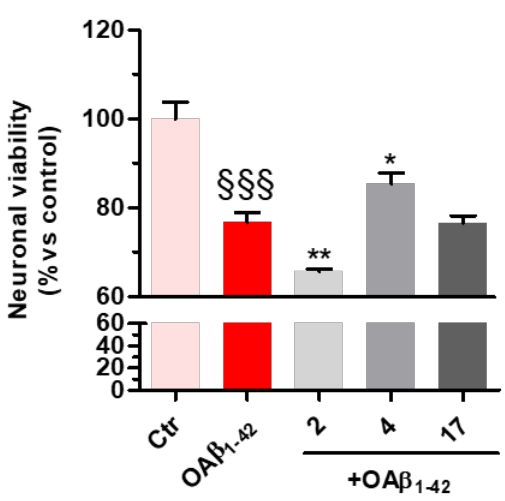
Figure 8. Effects of compounds 2 , 4 and 17 on the neurotoxicity induced by OA β 1–42 in SH-SY5Y cells. Cells were incubated with compounds 2 , 4 , 17 (1.25 µ M) and OA β 1–42 (10 µ M) for 4 h. At the end of incubation, the neuroprotective activity of the compounds was detected by the solubilization of intracellular MTT granules in Tween-20, as described in the Materials and Methods section. Data are expressed as percentage of neuronal viability and reported as mean ± SEM of three independent experiments ( §§§ p < 0.001 vs. control, * p < 0.05 and ** p < 0.01 vs. cells treated with OA β 1–42 at one way ANOVA with Bonferroni post hoc test).